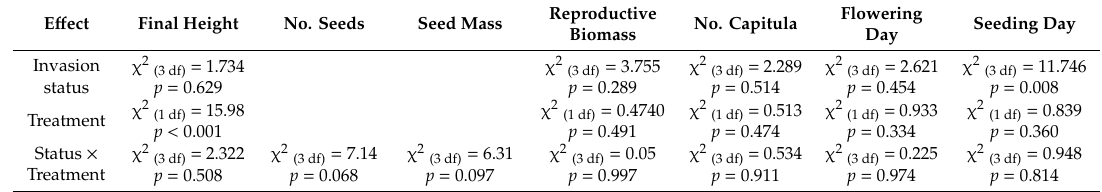
Table 1. Likelihood ratio tests for final height, number of seeds, seed mass, reproductive biomass, number of capitula, flowering day and day of seed ripening tested against invasion status, treatment and their interaction. If the interaction was not (marginally) significant, it was removed from the model and then the main e ff ects tested. (Marginally) significant values are indicated in bold